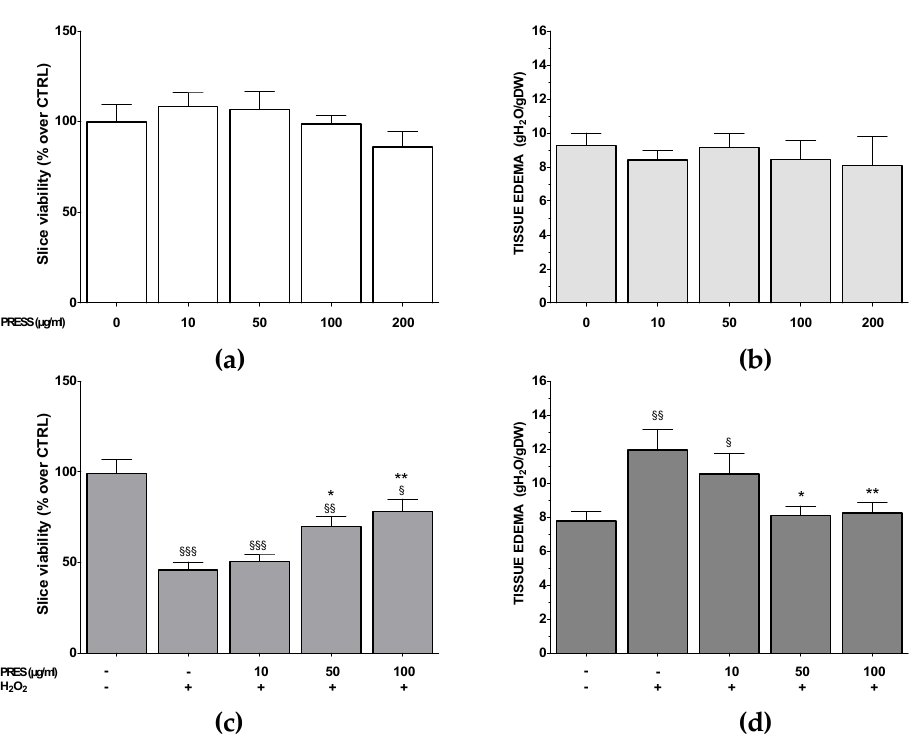
Figure 7. Effects of PRES on OS-induced reduction in rat brain slices viability and water content (tissue edema). ( a , b ): effects of PRES per se (10–200 µg/mL, 2 h) on tissue viability (MTT assay) and edema, respectively. ( c , d ): Slices were incubated with artificial cerebrospinal fluid (ACSF) (controls) or ACSF + PRES (10–100 µg/mL for 1 h). Afterward, PRES was maintained H 2 O 2 (10 mM for 1 h) was added. Data are reported as means ± SEMs. §§§ p < 0.001, §§ p < 0.01, § p < 0.05 vs. untreated slices; * p < 0.05, ** p < 0.01 vs. H 2 O 2 (ANOVA followed by Bonferroni post-test).